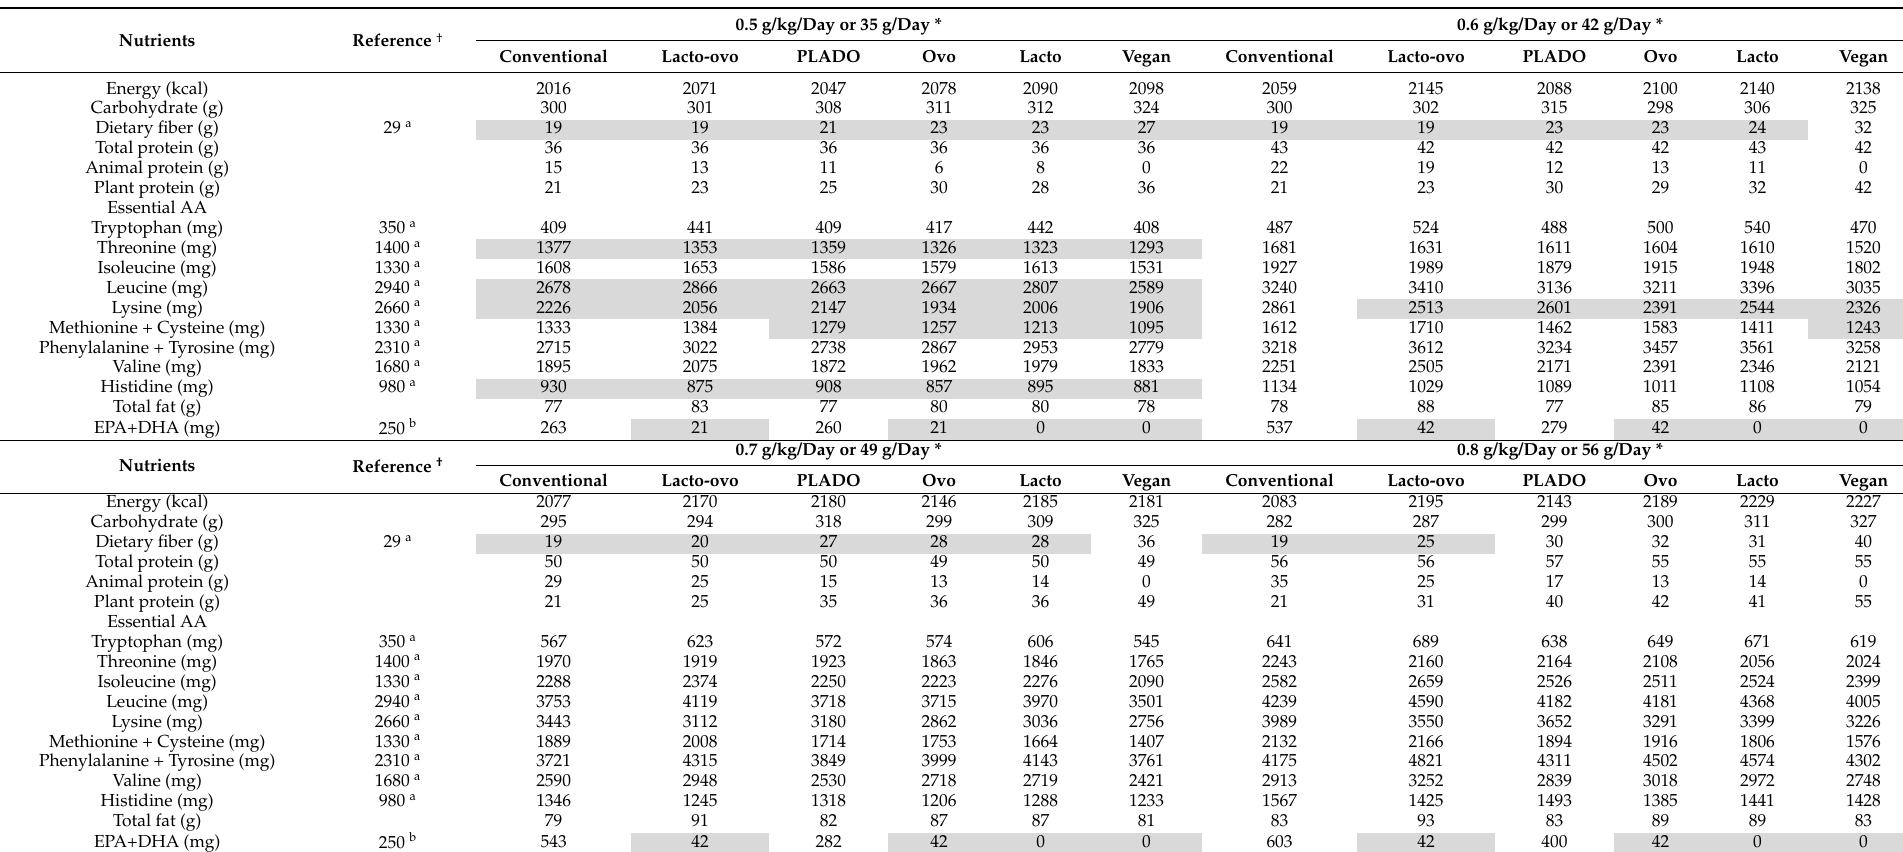
Table 2. Macronutrients, essential amino acid, and long-chain n -3 polyunsaturated fatty acid content of conventional, plant-based, and vegetarian low protein